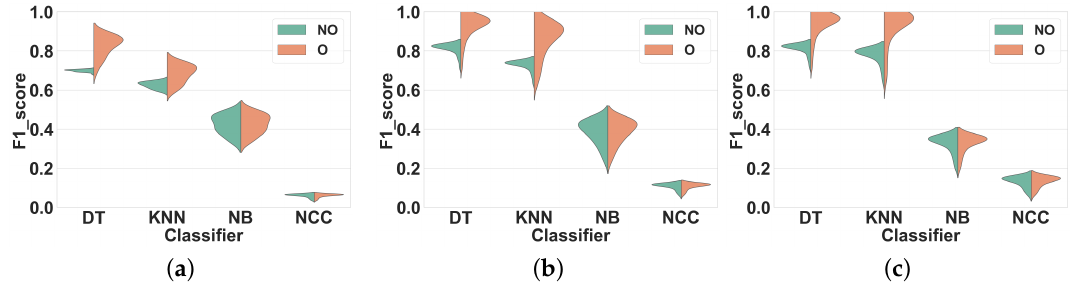
Figure 6. Experiment 1–Subject-dependent CV–Dataset 2. ( a ) FS1; ( b ) FS2; ( c )